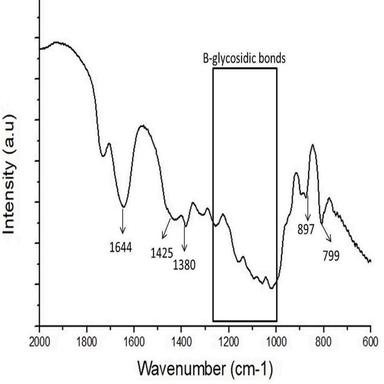
Infrared spectra of glucomannan powder.